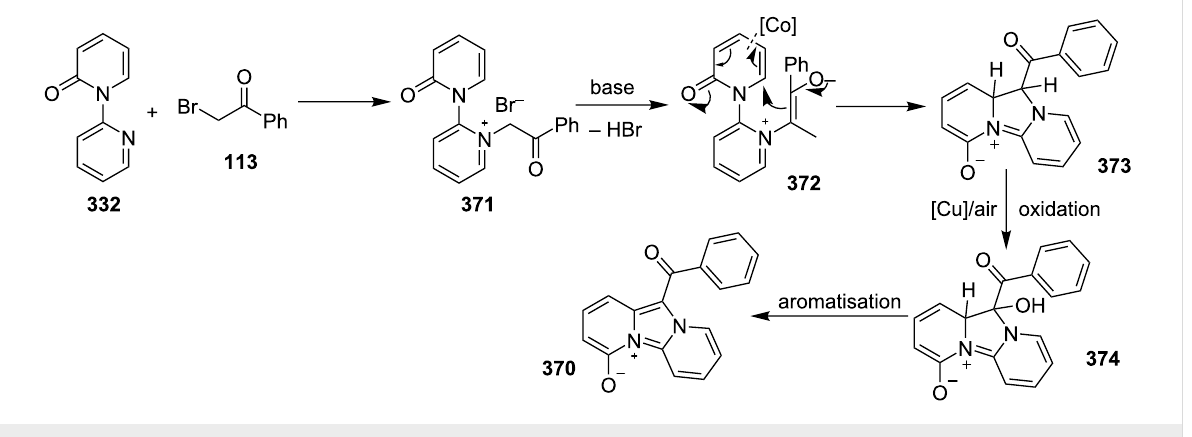
Scheme 124: Mechanistic scheme for the synthesis of imidazodipyridiniums.